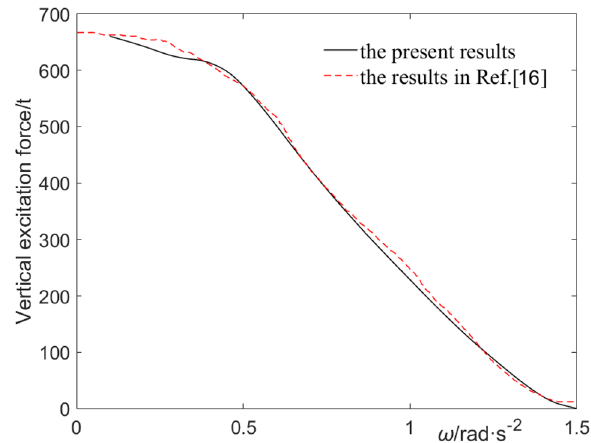
Fig. 6 Comparison results of the maximum vertical acceleration for each pontoon